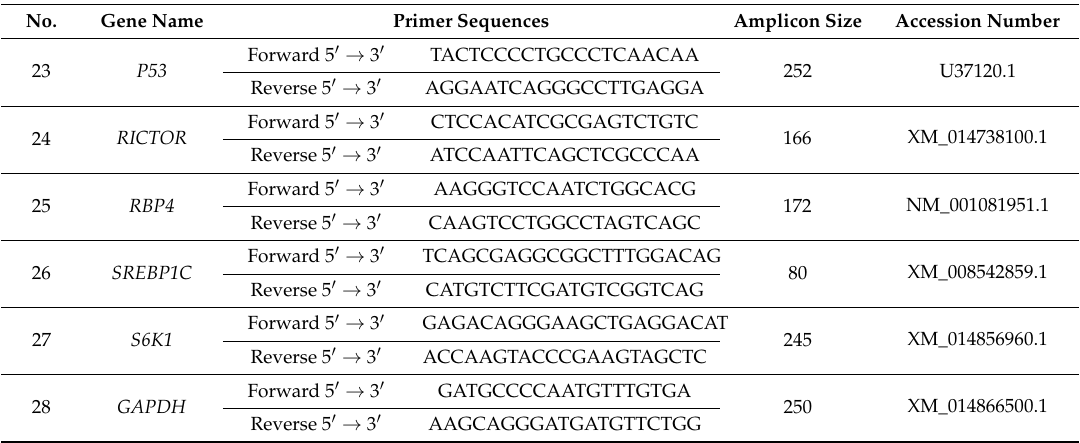
Table 2. Sequences of primers used in